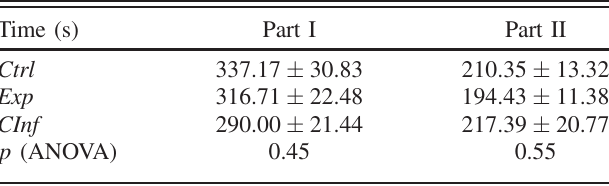
TABLE V. Average total time spent on each part of the multimedia tutorial.